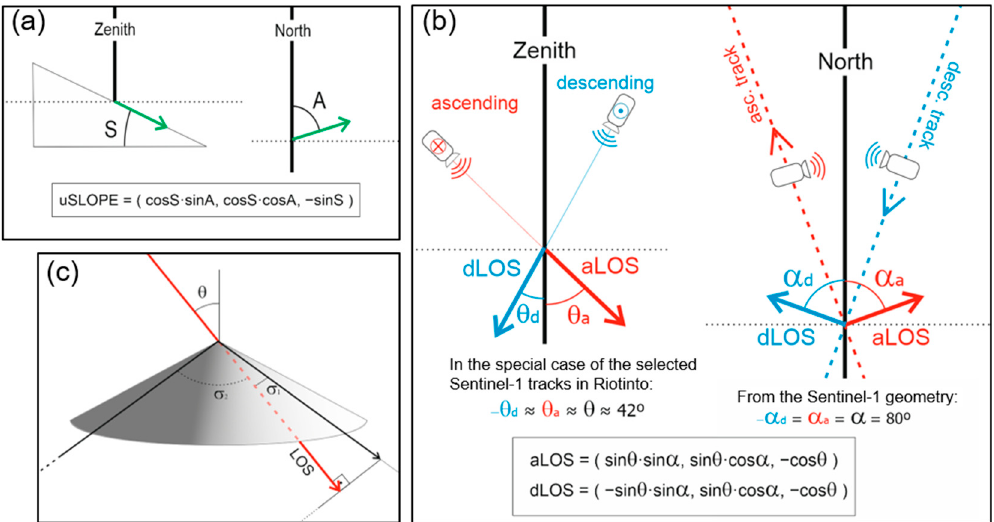
Figure 7. ( a ) Geodetic components of the slope unit vector in slope, uSLOPE. ( b ) Geometry of the line of sight (LOS) unit vector and geodetic components ascending, aLOS, and descending, dLOS. ( c ) Cone of all possible slopes and two angles ( σ ) with a LOS vector. Projecting LOS to the slope goes to extremely high values when σ approaches 90° ( σ 2).